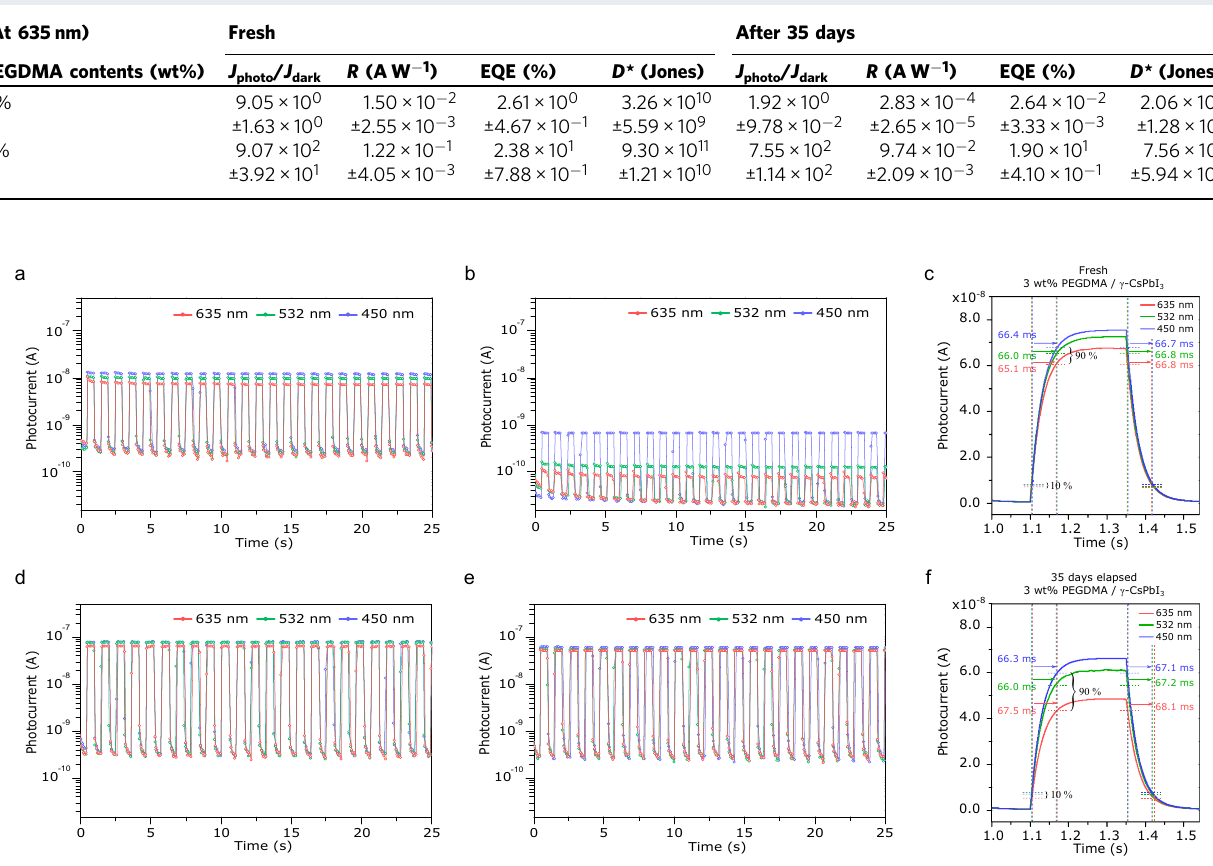
Fig. 5 Time-resolved photoresponse and transient response time of the optimized γ -CsPbI 3 (3 wt% PEGDMA) photoresistor. a , b Photocurrent – time responses of the reference γ -CsPbI 3 photoresistor at fresh state ( a ) and after 35 days ( b ) at 40 V applied bias. c , f The transient response time of the γ -CsPbI – time responses of the γ -CsPbI 3 (3 wt% PEGDMA) photoresistor at fresh state ( c ) and after 35 days ( f ). d , e Photocurrent 3 (3 wt% PEGDMA) photoresistor at fresh state ( d ) and after 35 days ( e ). Photocurrent – time response was measured at 40 V applied bias in the dark and under illumination using the LEDs at 635, 532, 450 nm with fi xed light intensity ( P in = 0.4 mWcm − 2 ) and frequency (1 Hz). The transient response time was measured at the 10th period during the 2 Hz, 50% duty cycle with fi xed light intensity ( P in = 0.4 mWcm − 2